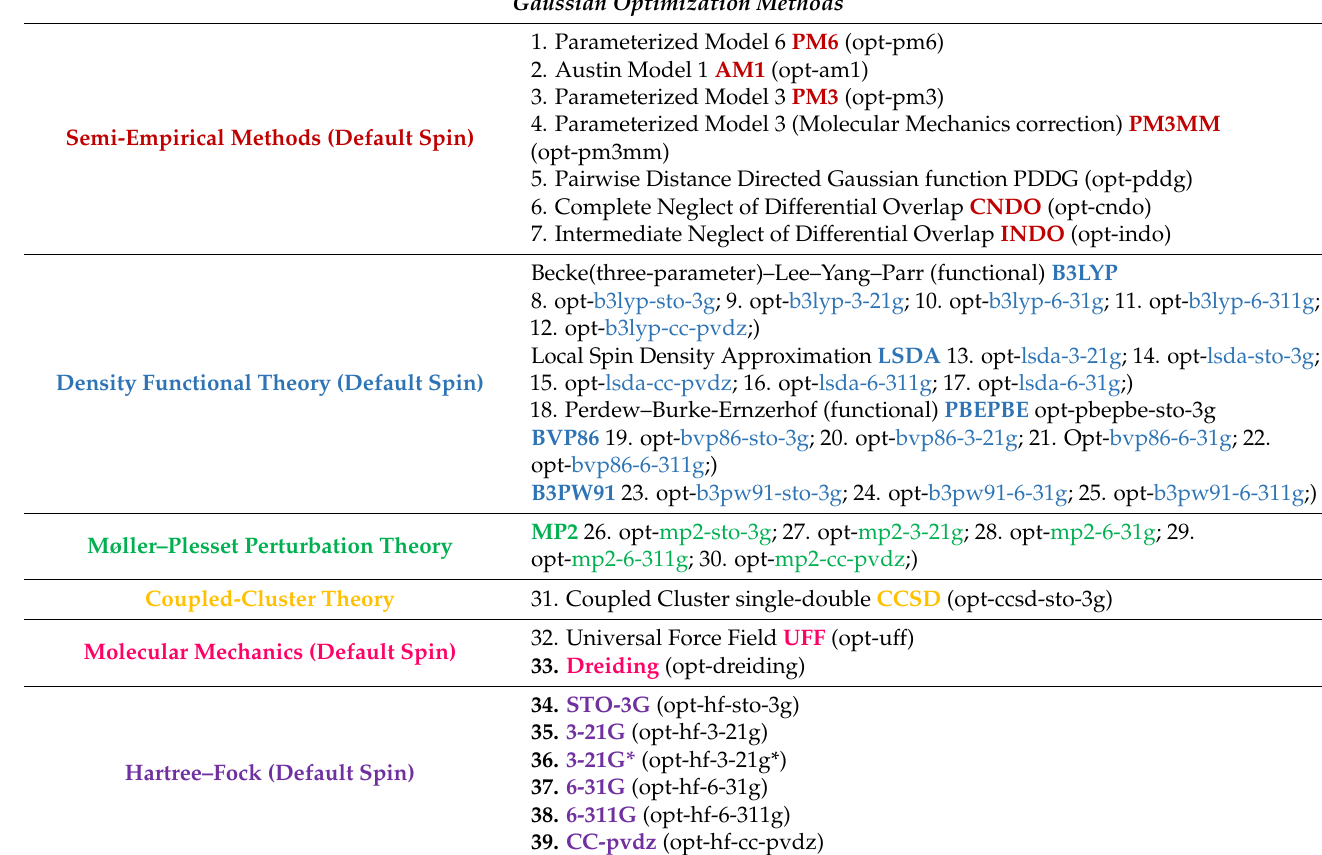
Table 2. Geometry optimization methods used in the